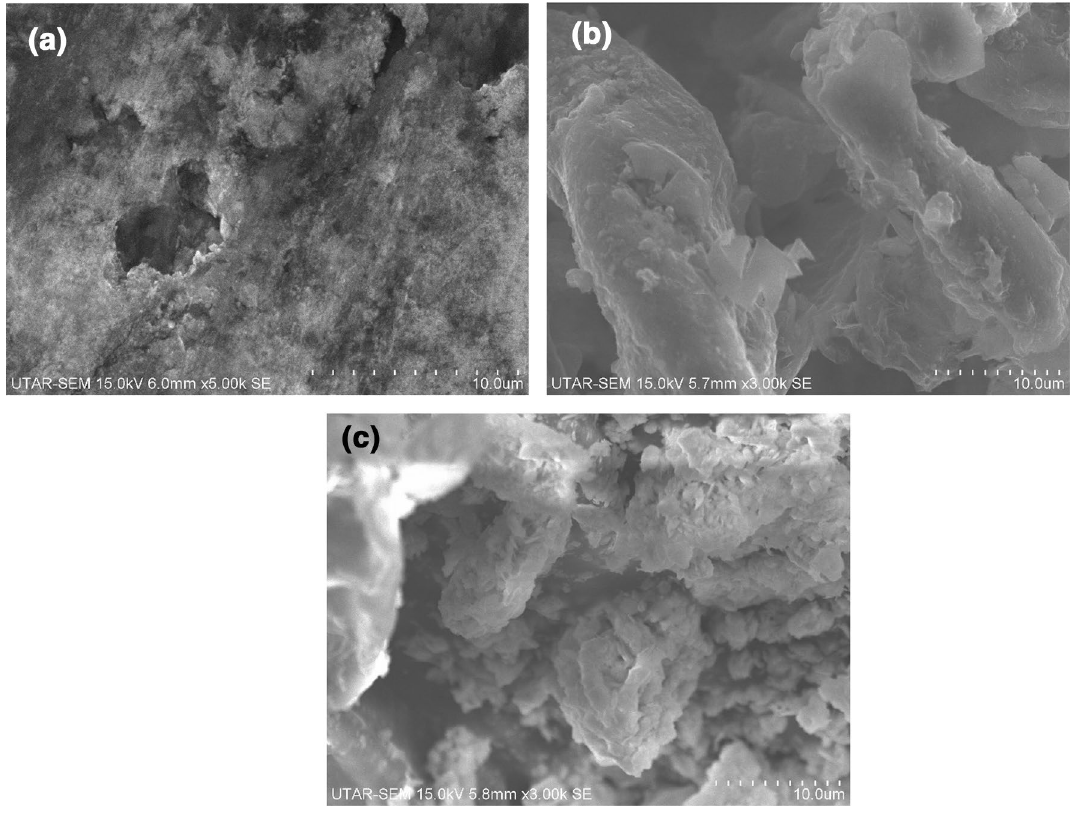
Fig. 5 SEM micrographs of ( a ) UA carbon, ( b ) G1, and ( c )